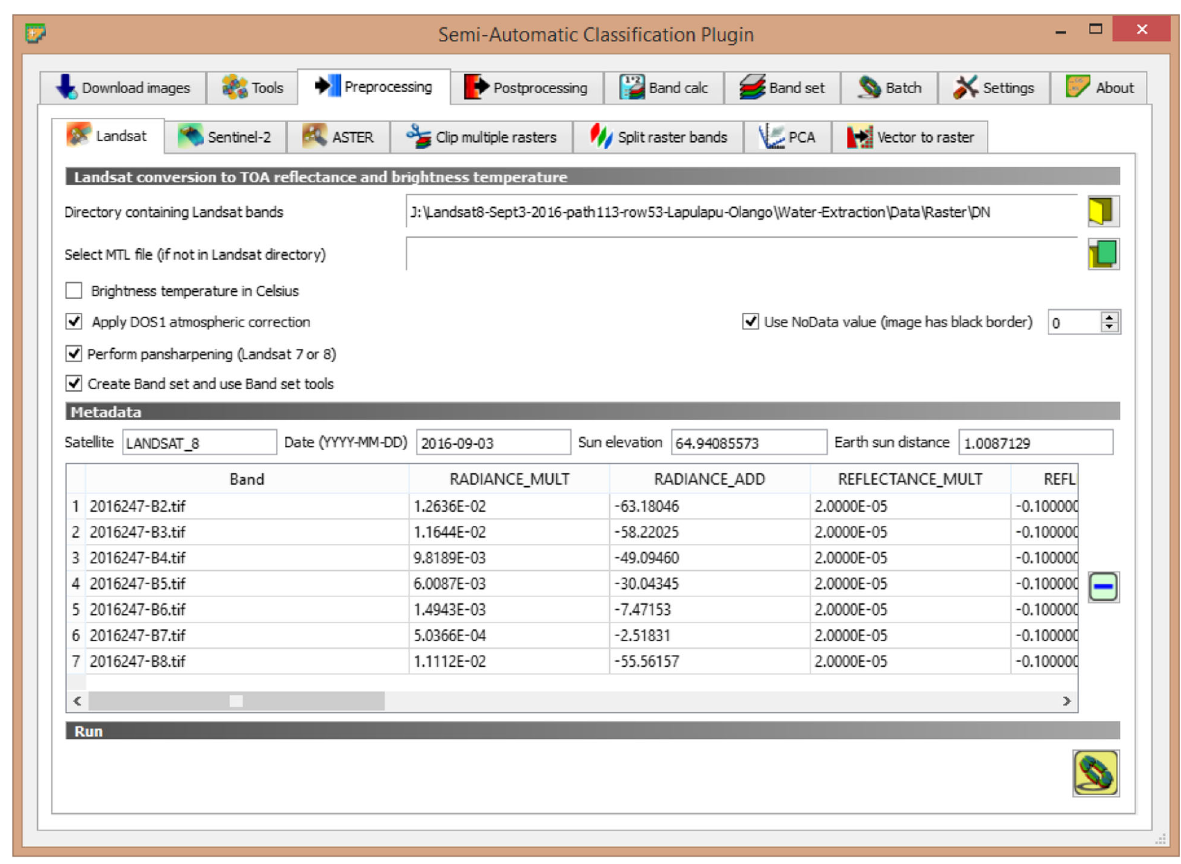
Fig. 3 Landsat conversion of DN to TOA reflectance and pan-sharpening with DOS1 atmospheric